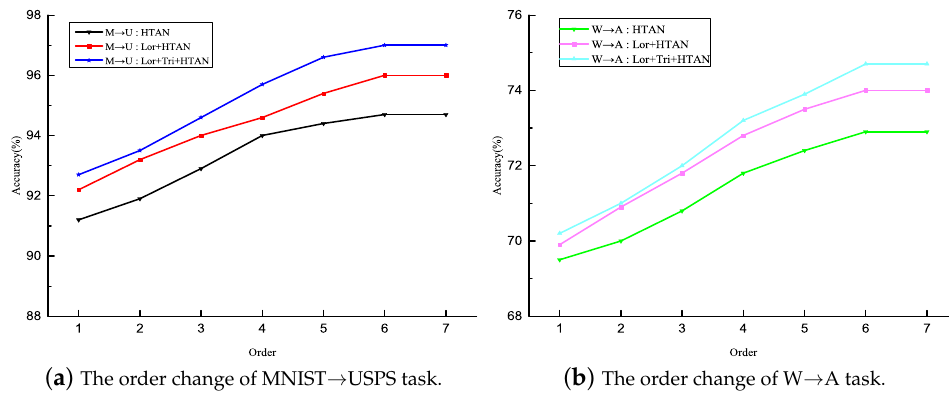
Figure 7. The influences of different orders on the migration